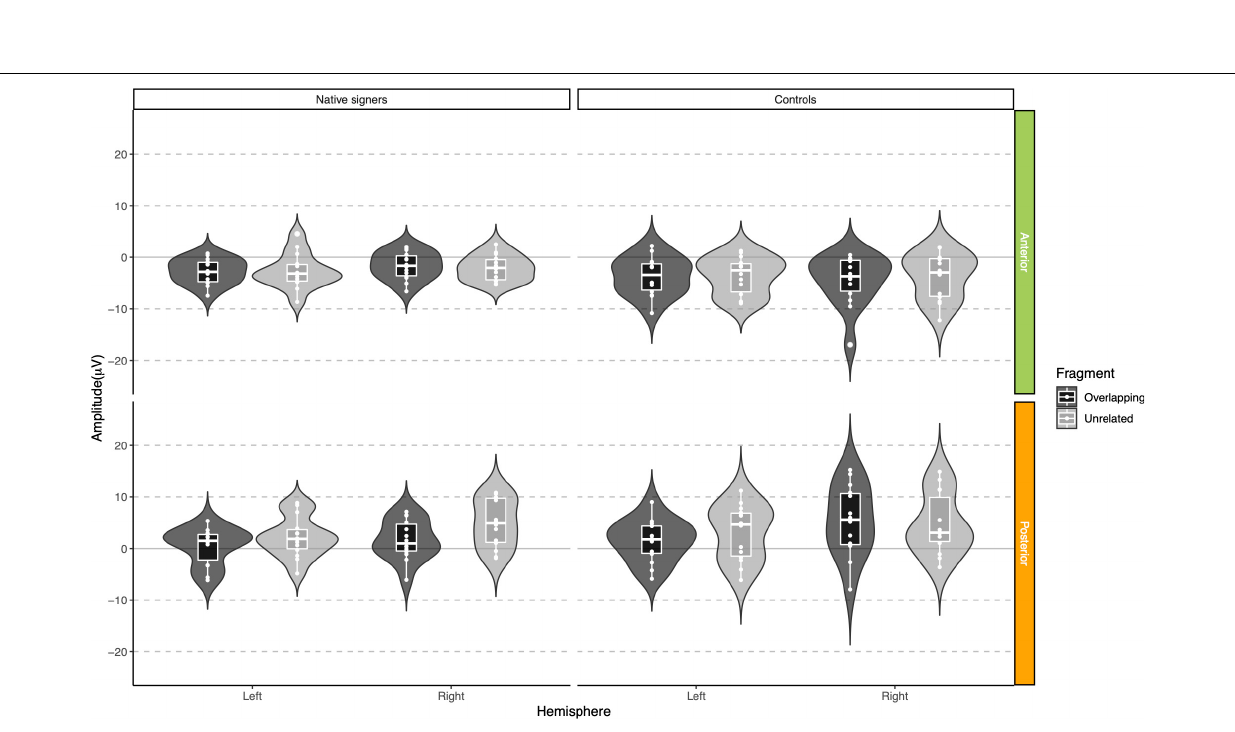
FIGURE 10 | Violin-boxplots depicting mean amplitude for the N400/negativity in the 400–600 ms time window for Native signers (left) and Controls (right) for the Unrelated (light gray) and Overlapping (dark gray) fragments across regions of